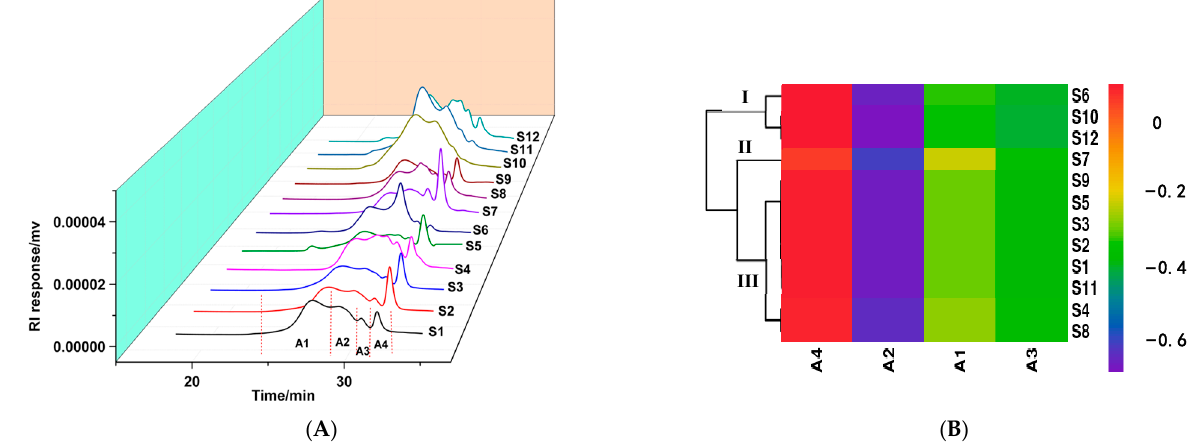
Figure 2. Molecular weight distribution of Ganoderma lucidum polysaccharides. HPSEC fingerprint ( A ), hierarchical cluster analysis of HPSEC fingerprint ( B ).